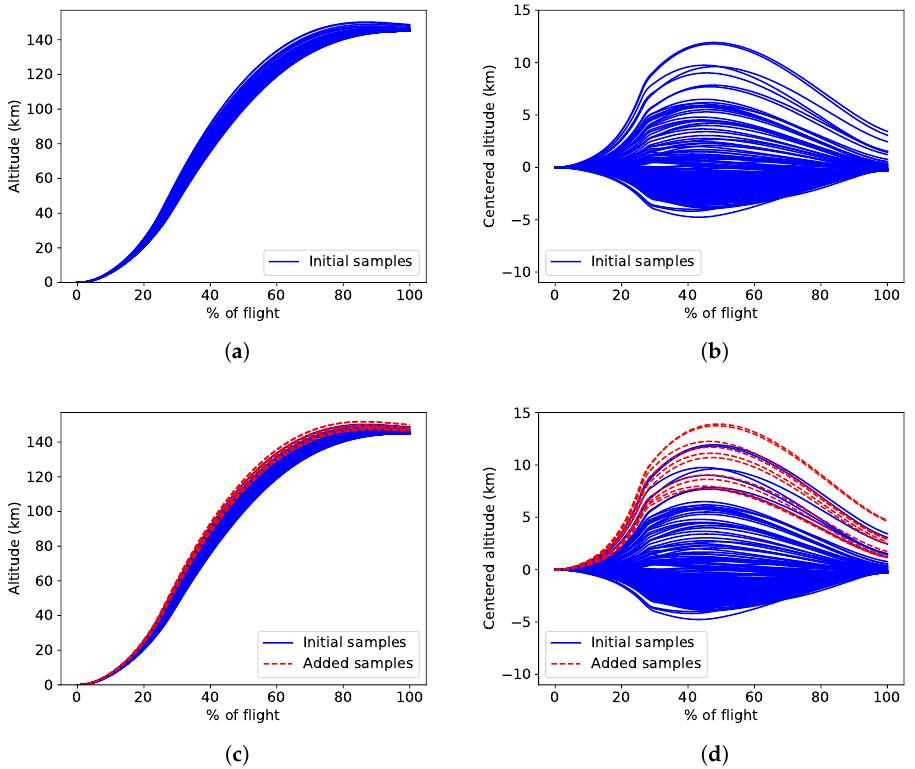
Figure 16. Initial and final output stochastic process samples for the altitude ( a , c ) and the centered altitude ( b , d